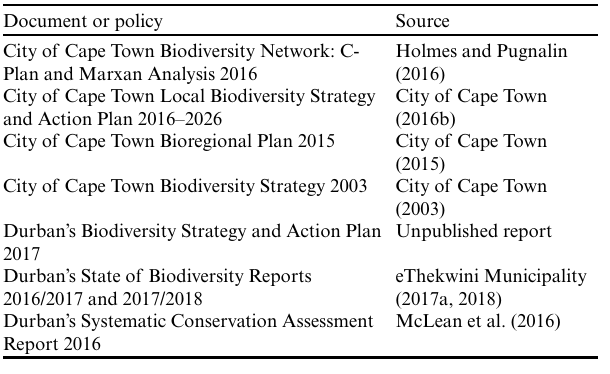
Table 1. List of documents and policies